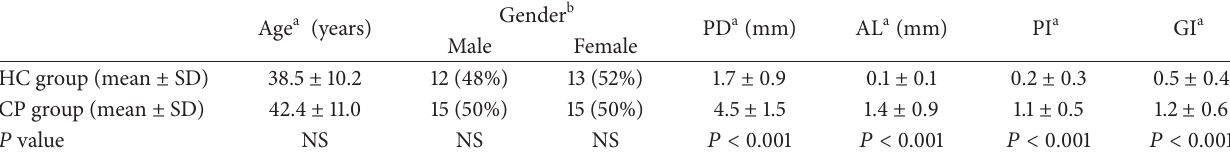
Table 1: Demographic characteristics and clinical parameters in HC and CP